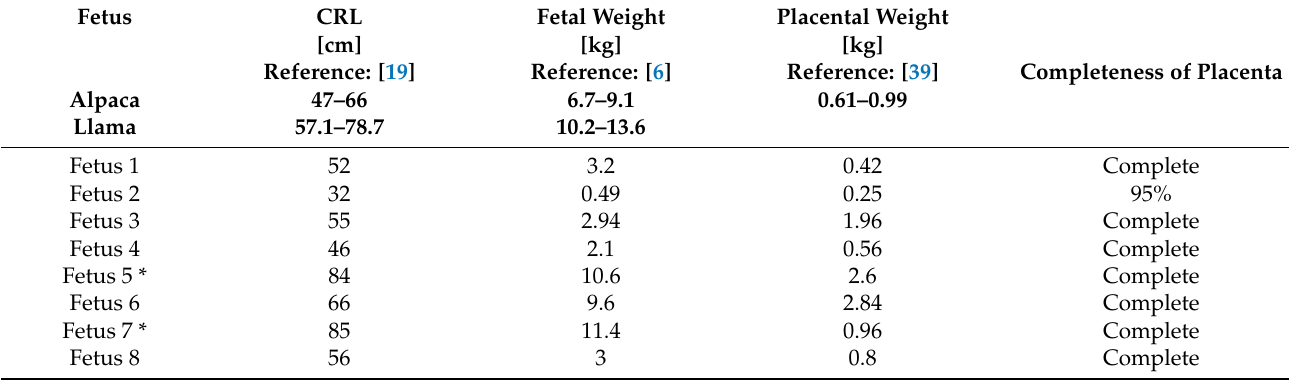
Table 1. Necropsy findings in 8 cases of abortion or stillbirth in 7 Swiss South American camelid herds.